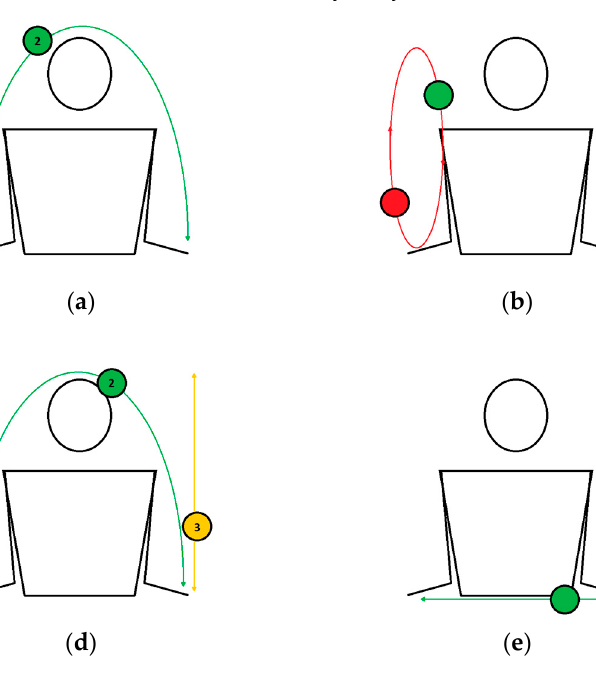
Figure 2. Various juggling exercises: ( a ) the one-handed column and the parabola; ( b ) the two-balls- in-one-hand fountain; ( c ) the one-handed column and the parabola with three balls at pace; ( d ) the three-ball “W”; ( e ) the zero throw; ( f ) the two-ball box.